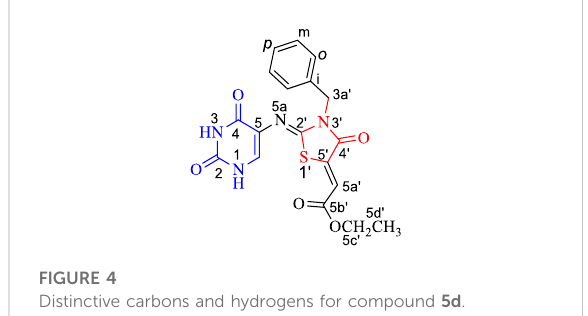
FIGURE 4 Distinctive carbons and hydrogens for compound 5d .